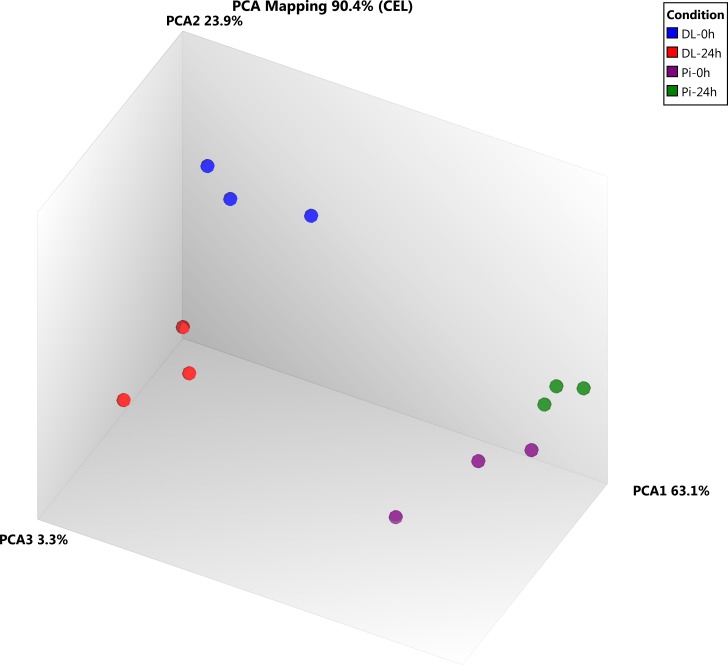
Principal component analysis (PCA) plot showing the sample characteristics based on microarray expression data.Each solid circle indicates the normalized gene expression of one microarray sample and the color of the circle indicate treatment condition.